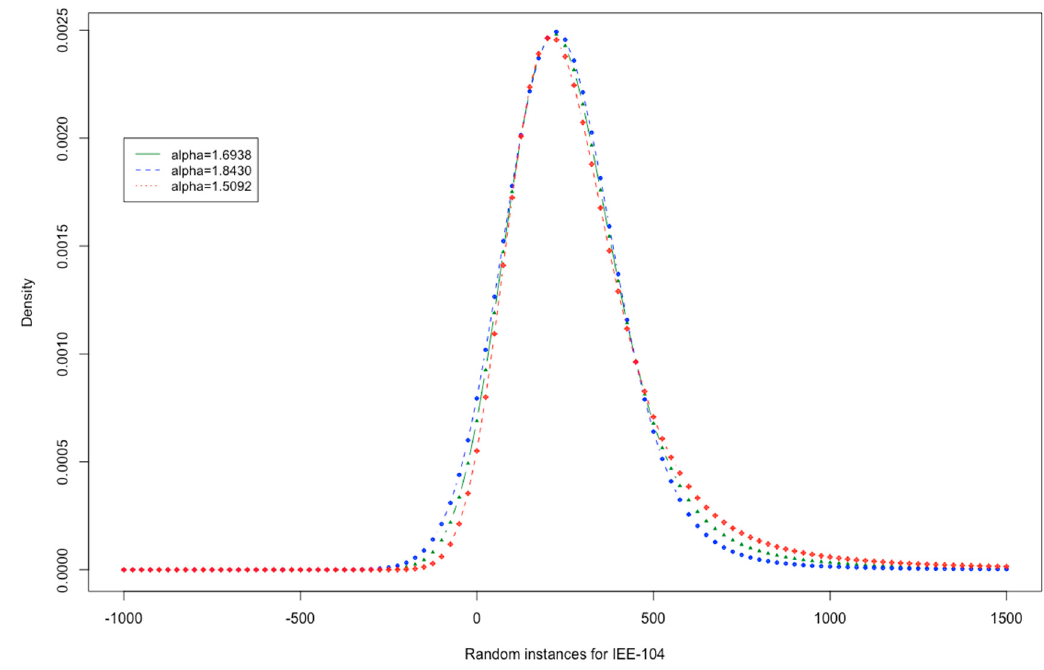
Figure 5. Alpha parameter effect (IEE-104).